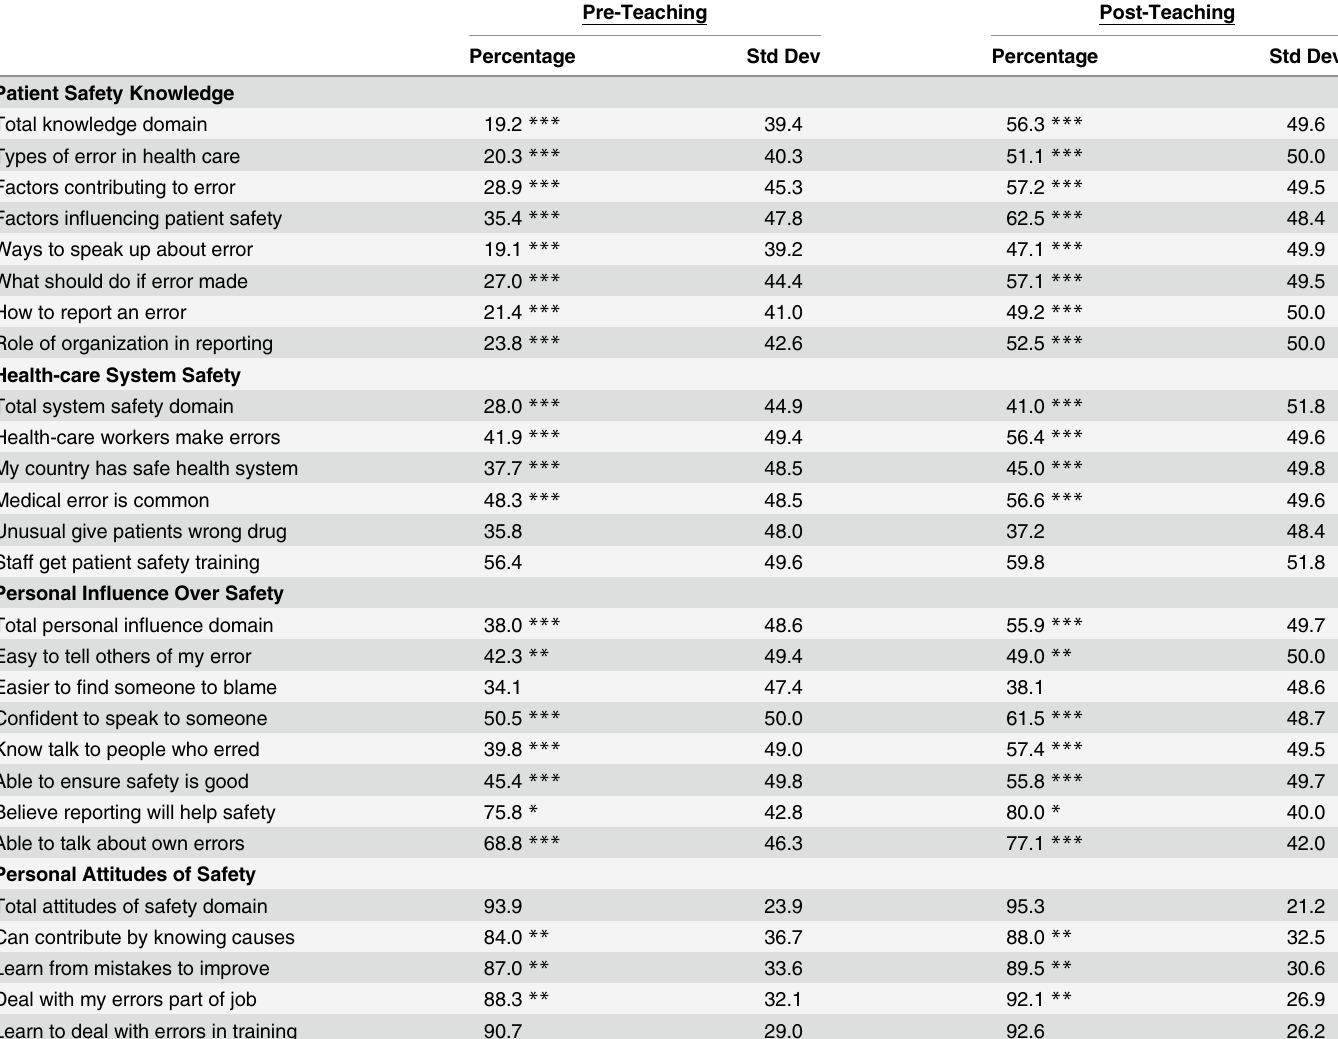
Table 3. Percentage of top responses by students on their knowledge and attitudes of patient safety, pre and post teaching.